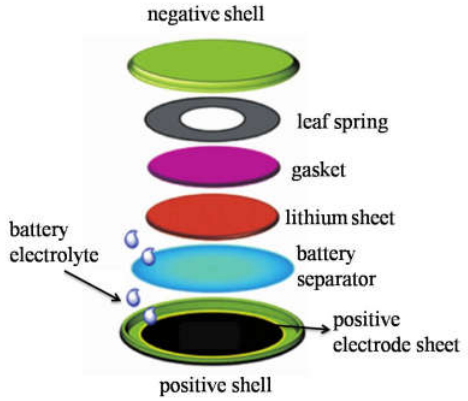
Figure 3. The sequence diagram of lithium battery assembly. Table 2. The main materials of the assembled lithium battery.